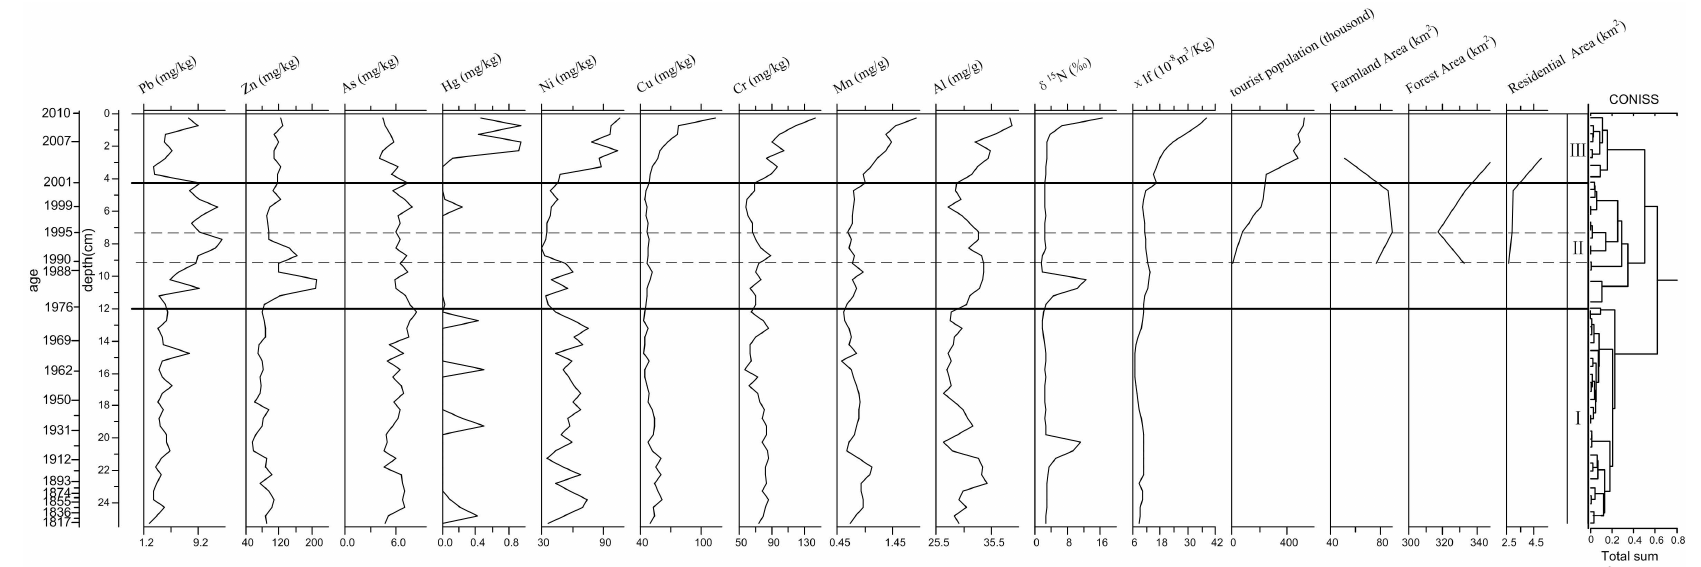
Figure 2. Vertical profiles of metals, nitrogen isotopes, and magnetic susceptibility in the Lugu Lake sediments and the tourist population in the watershed. On the right is the constrained incremental sum of squares (CONISS) based on elemental data. δ 15 N (nitrogen isotope ratios), χ lf (low frequency magnetic susceptibility). The tourist population, Farmland Area, Forest Area and Residential Area data (1989–2010 AD) were obtained from Don et al. [28] and Zhang et al.